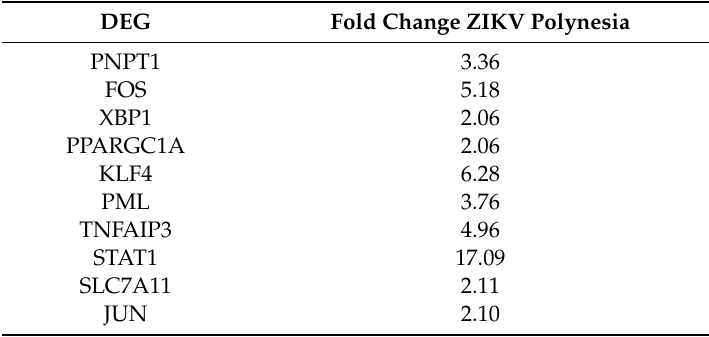
Table 5. Di ff erentially expressed genes (DEGs) during infection with ZIKV Polynesia at 72 hpi, which were annotated to GO-term ”response to oxidative stress”.